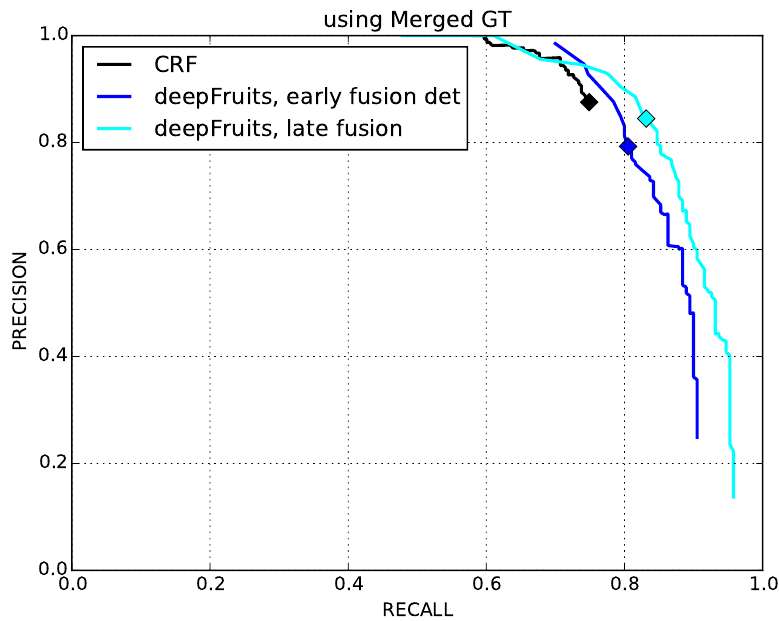
Figure 9. Precision-recall curves of the CRF baseline, early and late fusion networks. All make use of RGB and NIR images as inputs. Due to the performance issue of CRF, we calculate the F1 score slightly offset from the equilibrium